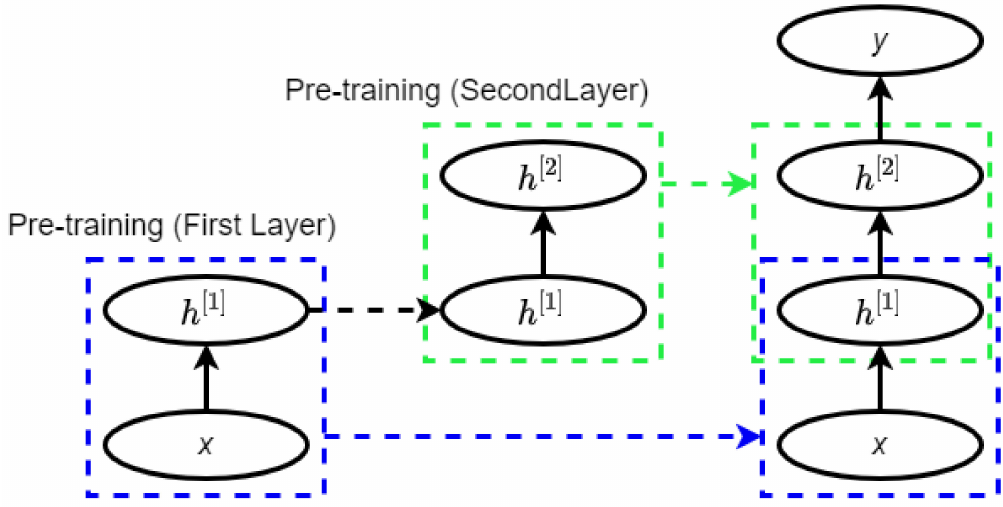
Figure 3. Pretraining of a deep belief network (DBN) (adopted from